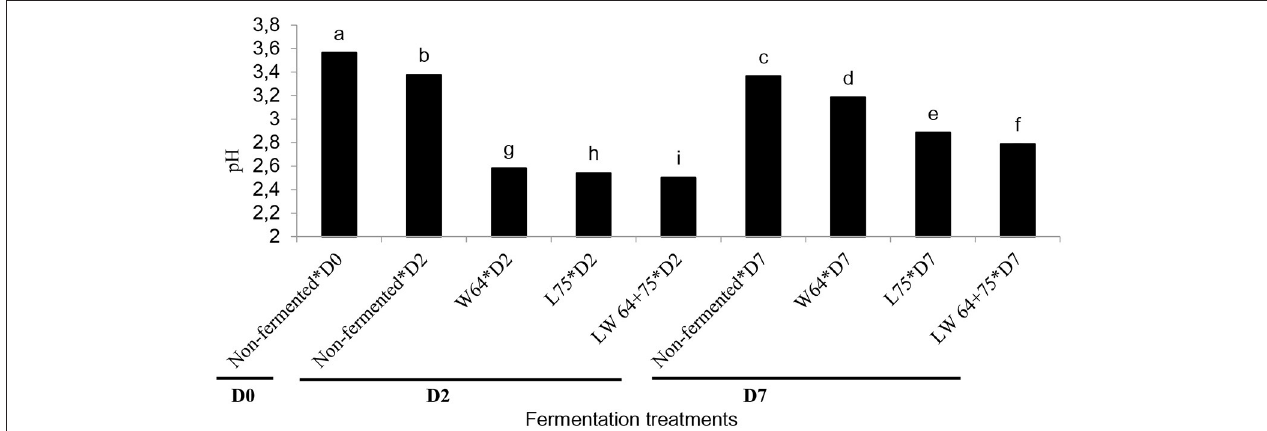
FIGURE 1 | Changes in pH value during lactic acid fermentation of smoothies. Bars with different alphabetic letters are significantly different at p < 0.0001 level. W64, Weissella cibaria 64; L75, Lactobacillus plantarum 75 ; LW64 + 75, W. cibaria 64 + L. plantarum 75; D0, day 0; D2, 2 days; D7, 7 days; non-fermented smoothies